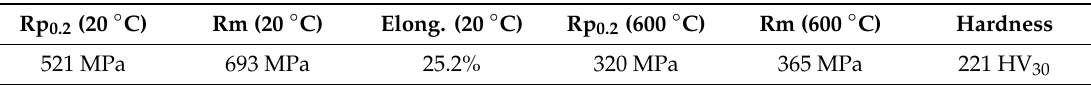
Table 2. Main mechanical properties of the parent metal SA 355 P91 (Data from Vallourec company).